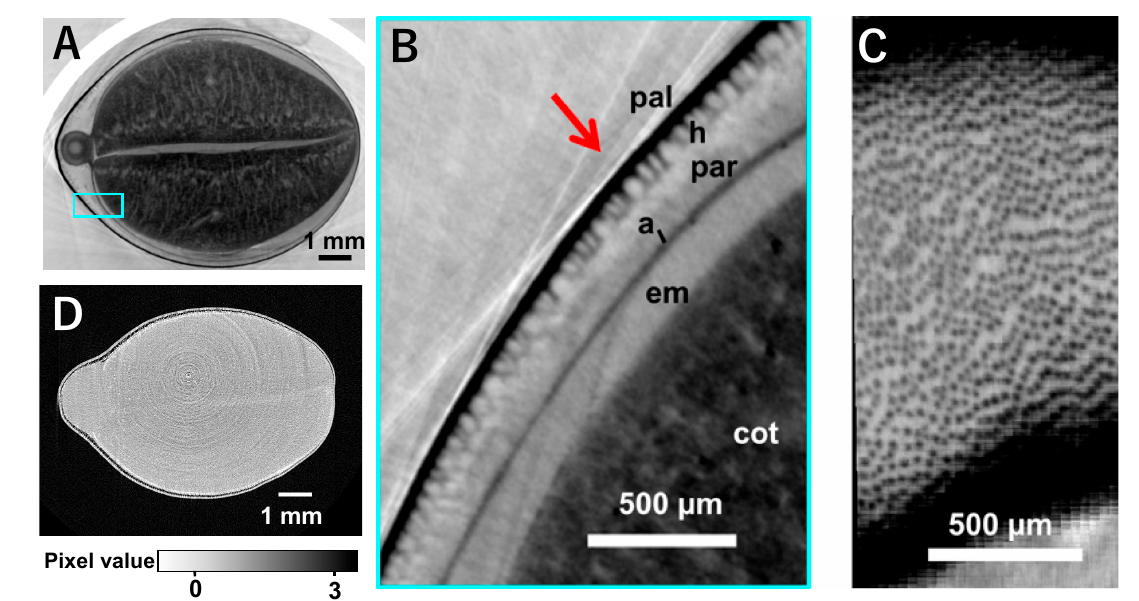
Figure 3. Images of X-ray phase-contrast CT ( A – C ). An X-ray absorption image ( D ) was taken for comparison with X-ray phase-contrast, and other images, whose pixel value represents phase shift, were prepared by X-ray phase-contrast. A tomogram of an edamame bean ( A , D ), high-resolution image (3.47 µm/pixel) of the epidermis of the edamame bean for the area indicated by the cyan square in A ( B ), and the cross-sectional image of the hourglass cell layer perpendicular to the red arrow in B ( C ). The black dots are assumed to be hourglass cells ( C ). Abbreviations in ( B ): pal, palisade layer; h, hourglass cell; par, parenchyma; a, aleurone cells; em, endosperm; cot, cotyledon.